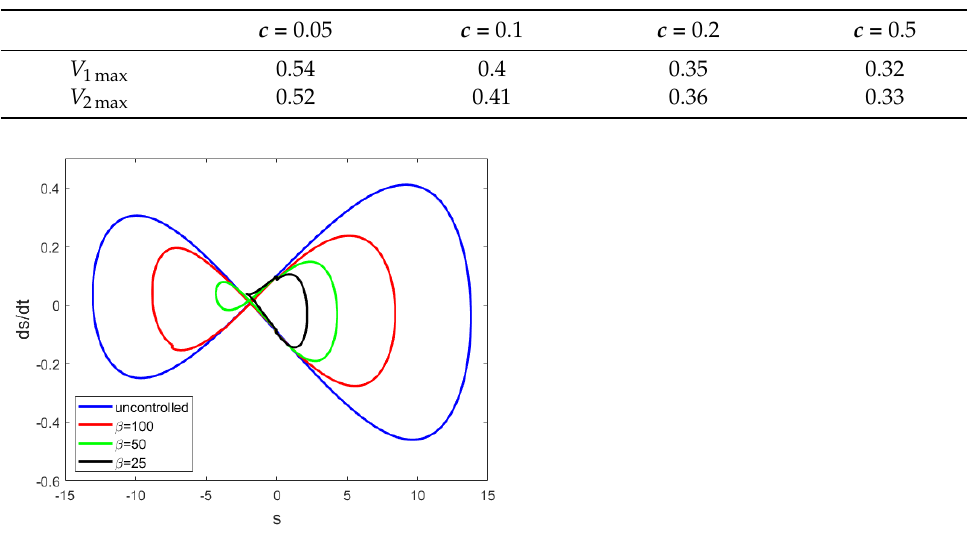
Figure 12. The phase portrait of manifold s and s Table 3. The maximum applied voltages V 1 and V 2 for various amounts of β and considering p = 19, q = 17, and c = 0.05.